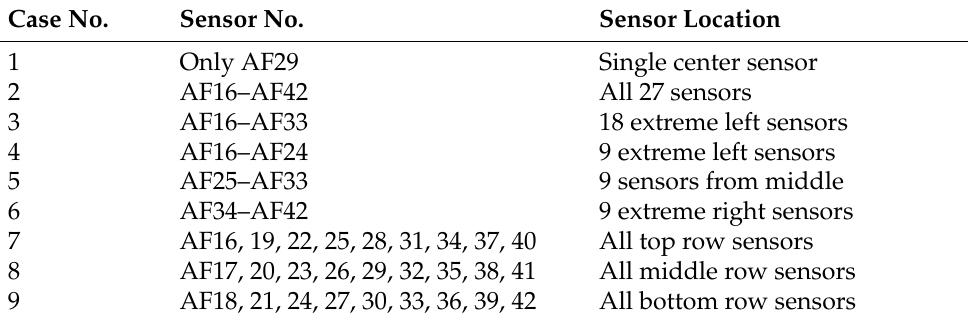
Table 2. Considering different number of sensors from the deployment and location (Figure 7) for